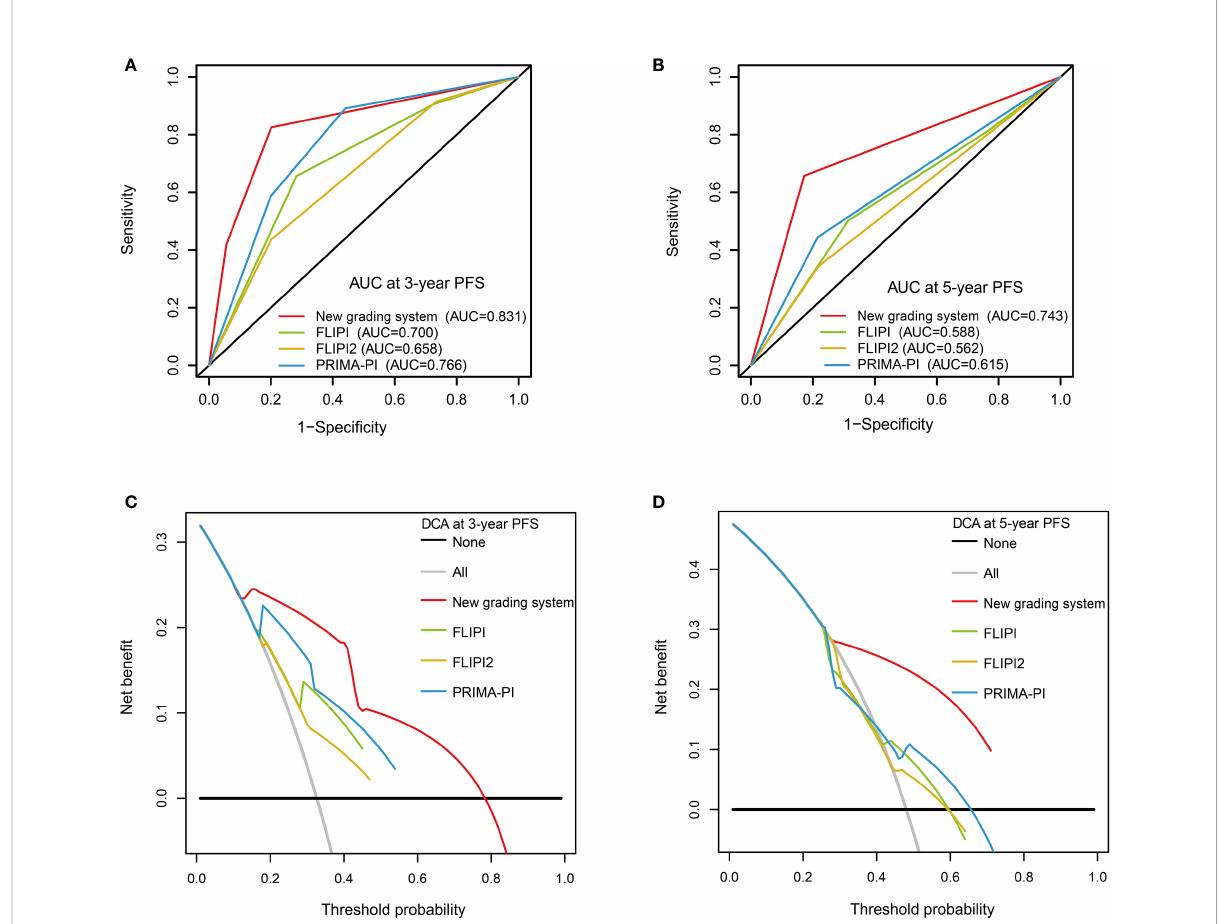
FIGURE 6 Receiver operating characteristic curves with the new grading system, FLIPI, FLIPI2, and PRIMA-PI for 3-year progression-free survival (PFS) (A) and 5-year PFS (B) . Decision curve analysis with the new grading system, FLIPI, FLIPI2, and PRIMA-PI for 3-year PFS (C) and 5-year PFS (D)